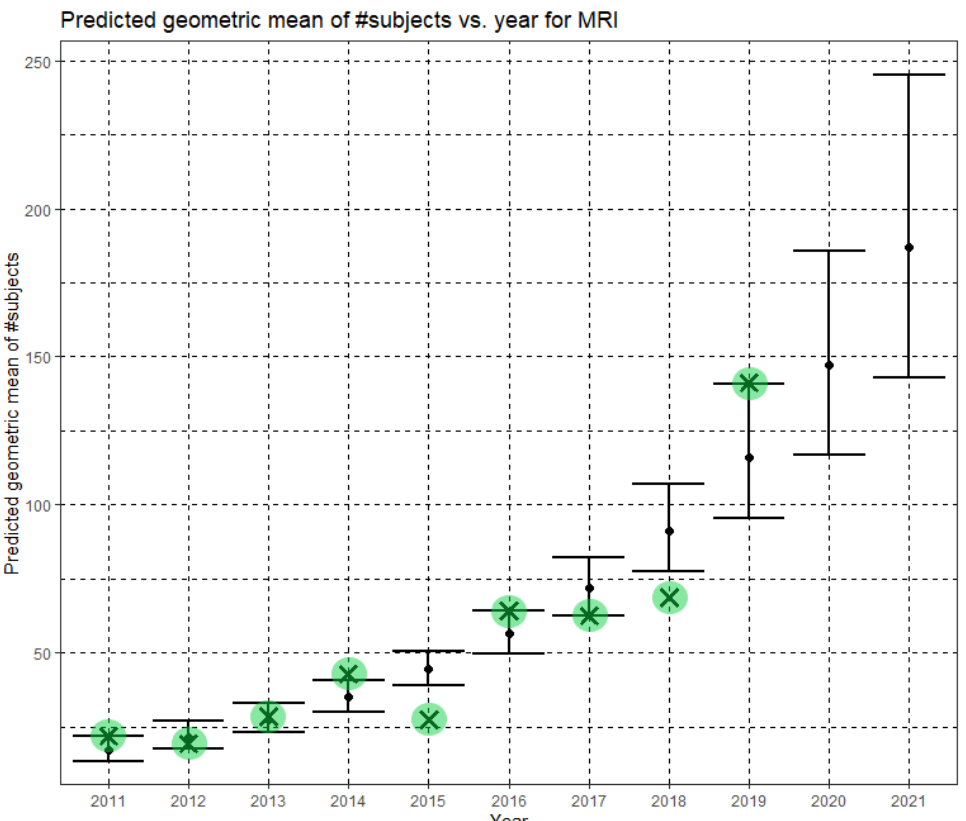
Figure 7. Phase II—Predicted geometric mean (black dots) and confidence intervals of dataset sizes in MICCAI articles involving MRI for the years 2011–2021 based on the whole ensemble of 2011–2019 MRI dataset sizes. The empirical geometric means (2011–2019) are shown (in green) for comparison (x marks). The empirical geometric means for 2020 and 2021 are not known at the time of writing .